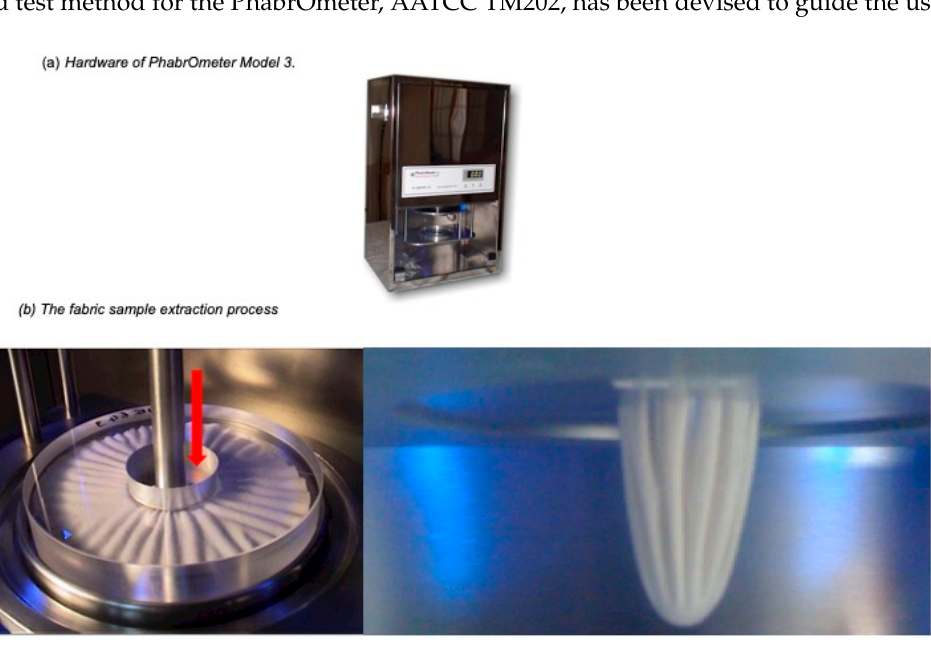
Figure 1. PhabrOmeter Model 3 Fabric Evaluation System: ( a ) hardware of PhabrOmeter Model 3; and ( b ) the fabric sample extraction process.